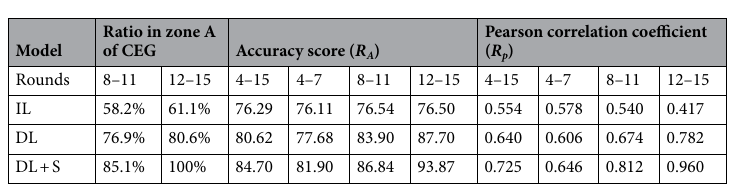
Table 2. Performance Summary of models in groups of